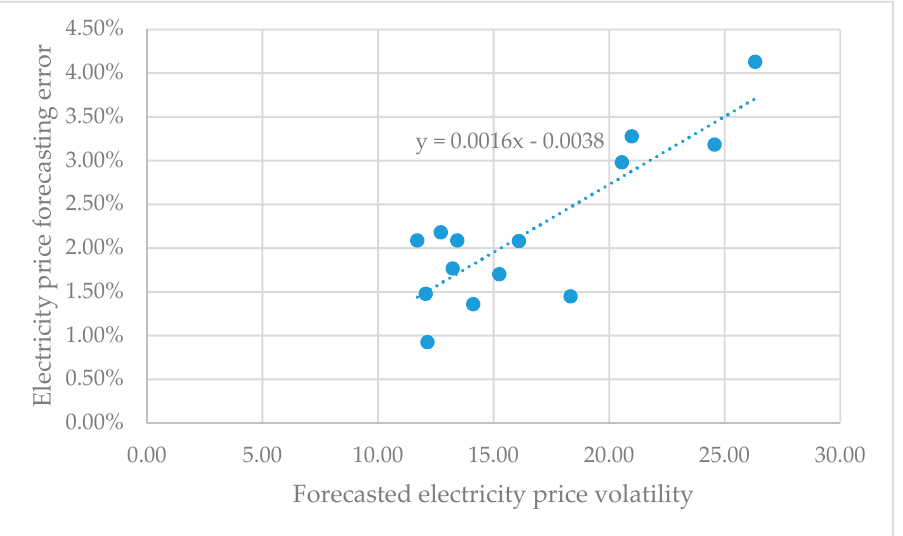
Figure 17 . Correlation between forecasting error and price volatility in second forecasting interval.